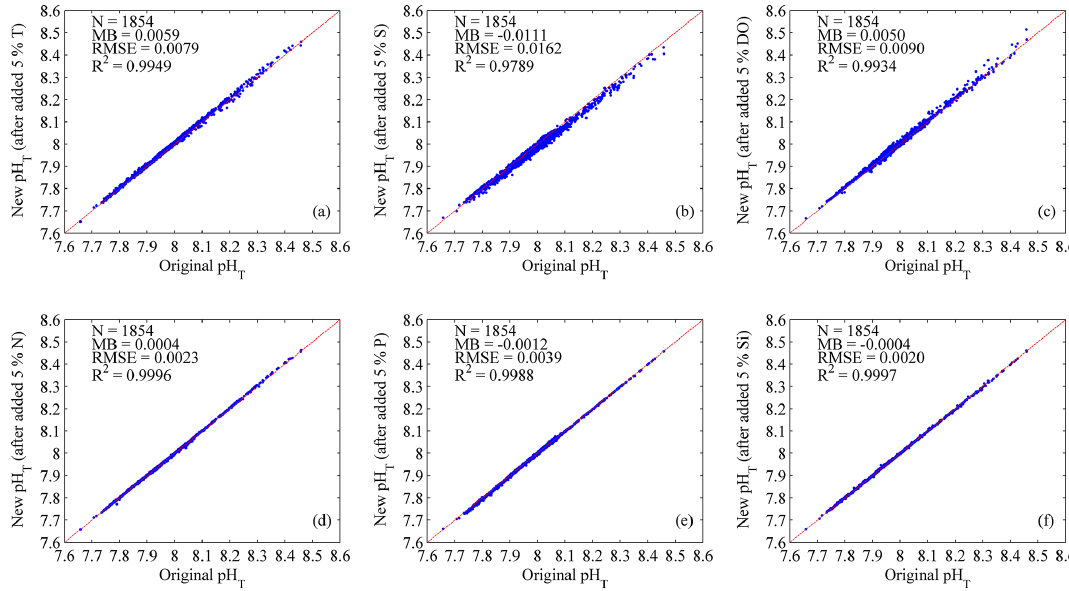
Figure 9. Sensitivity of the ANN model for environmental input variables. (a) Temperature ( T ); (b) salinity ( S ); (c) dissolved oxygen (DO); (d) nitrate (N); (e) phosphate (P); (f) silicate (Si). Three statistics approaches used are the mean bias (MB), the root mean square error (RMSE) and the coefficient of determination ( R 2 ). N represents the number of data